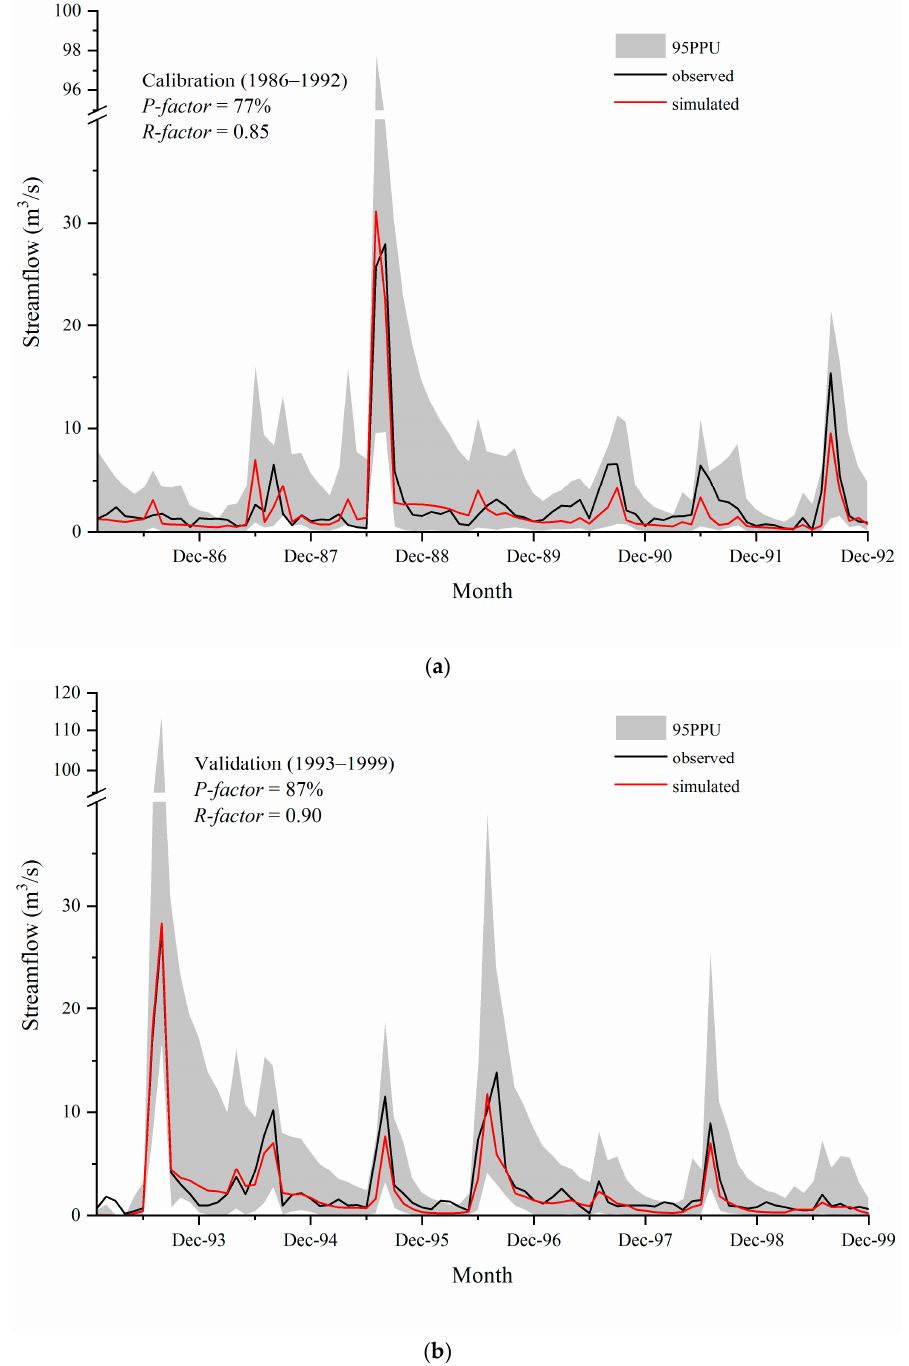
Figure 4. Ninety-five percent probability uncertainty plot and comparison of best simulated and observed streamflow for the calibration ( a ) and validation period ( b ).